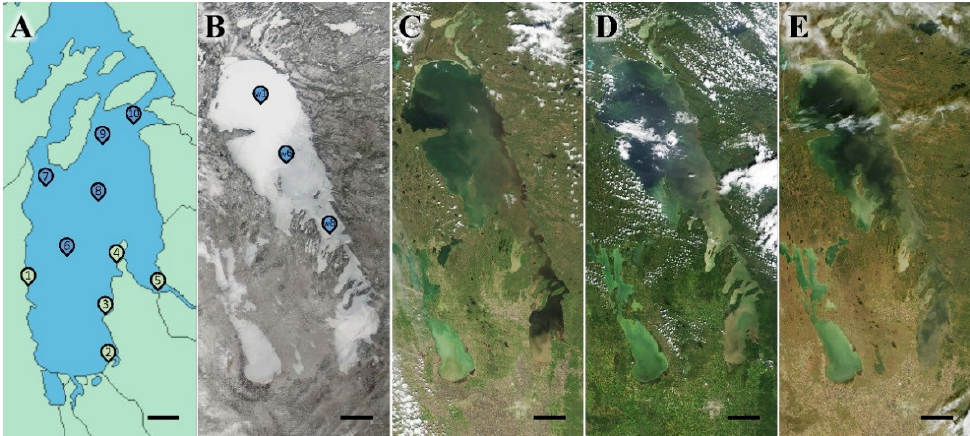
Figure 1. Lake Winnipeg seasonal progression and sampling locations. ( A ) Map of the South Basin of Lake Winnipeg, with littoral (green) and limnetic (blue) sites selected for study: S1–5, S6–10 (W1, W6, and W8 alternatively), respectively; Scale bar, 10 km. Satellite images of entire waterbody depicting seasonal change to lake habitat and surrounding lands during ( B ) Winter, 26 March 2017 indicating additional under-ice sites, ( C ) Spring, 31 May 2017, ( D ) Summer, 3 August 2017, and ( E ) Fall, 11 October 2017; Scale bars, 40 km. Photographs provided by Dr. K. Scott and the Lake Winnipeg Research Consortium (LWRC), in partnership with the Rapid Response Imagery from the Land Atmosphere Near-real time Capability for EOS (LANCE) system operated by the NASA/GSFC/Earth Science Data and Information System (ESDIS).